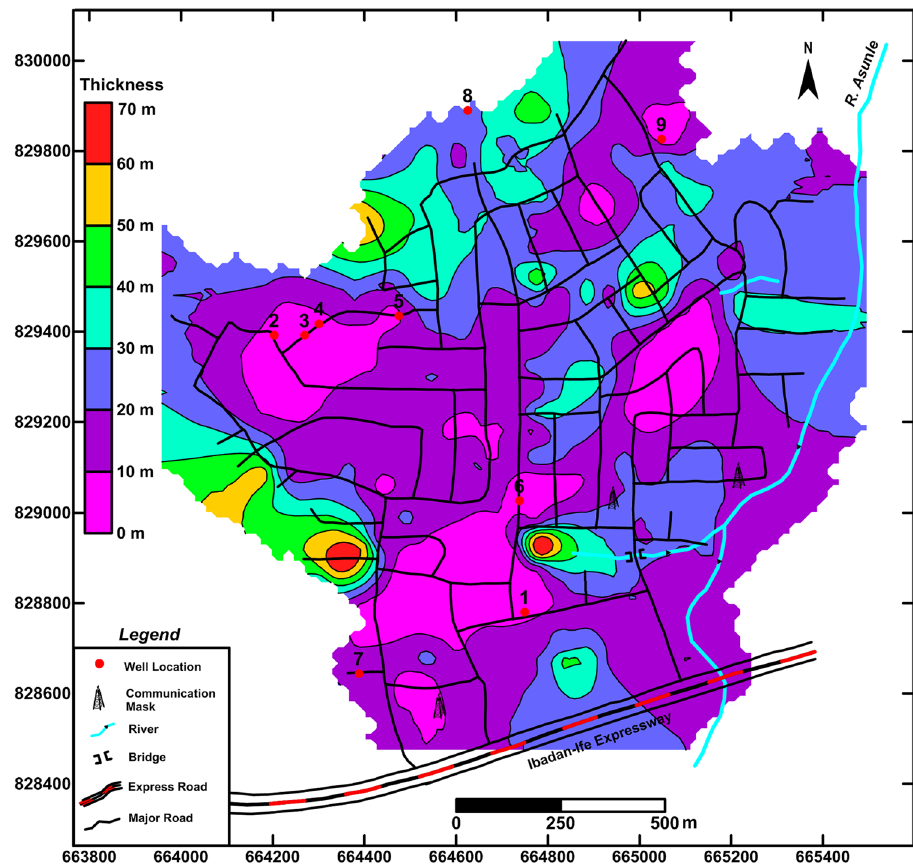
Fig. 12 Magnetic overburden thickness map with superim- posed well